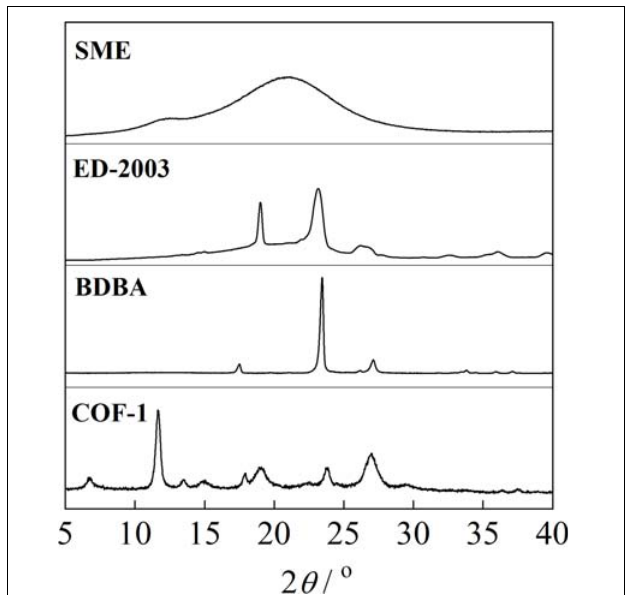
FIGURE 5 | PXRD patterns of BDBA, COF-1, ED-2003, and SME.